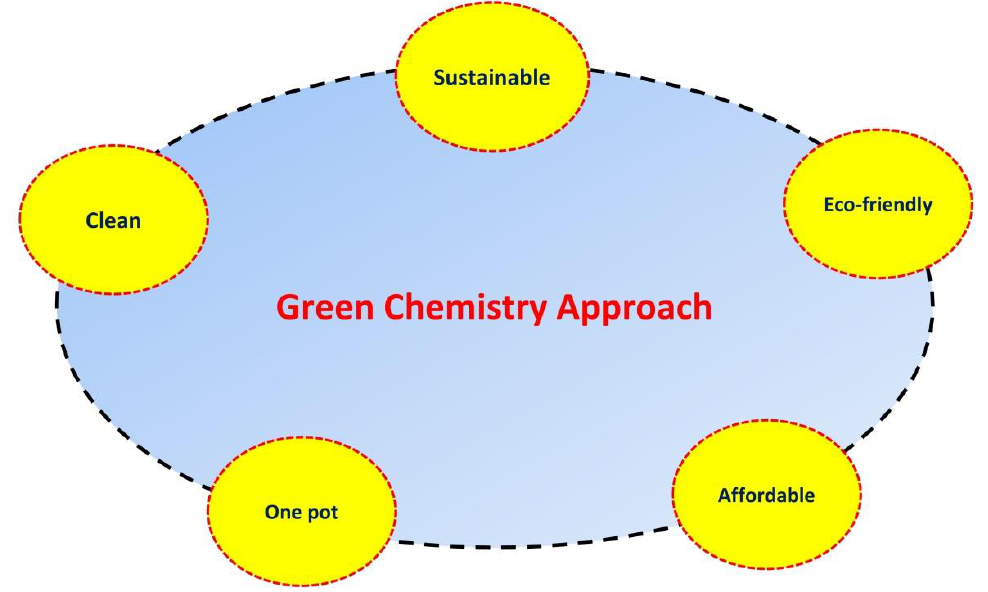
Fig. 2. Importance of green Figure 2. Importance of green chemistry